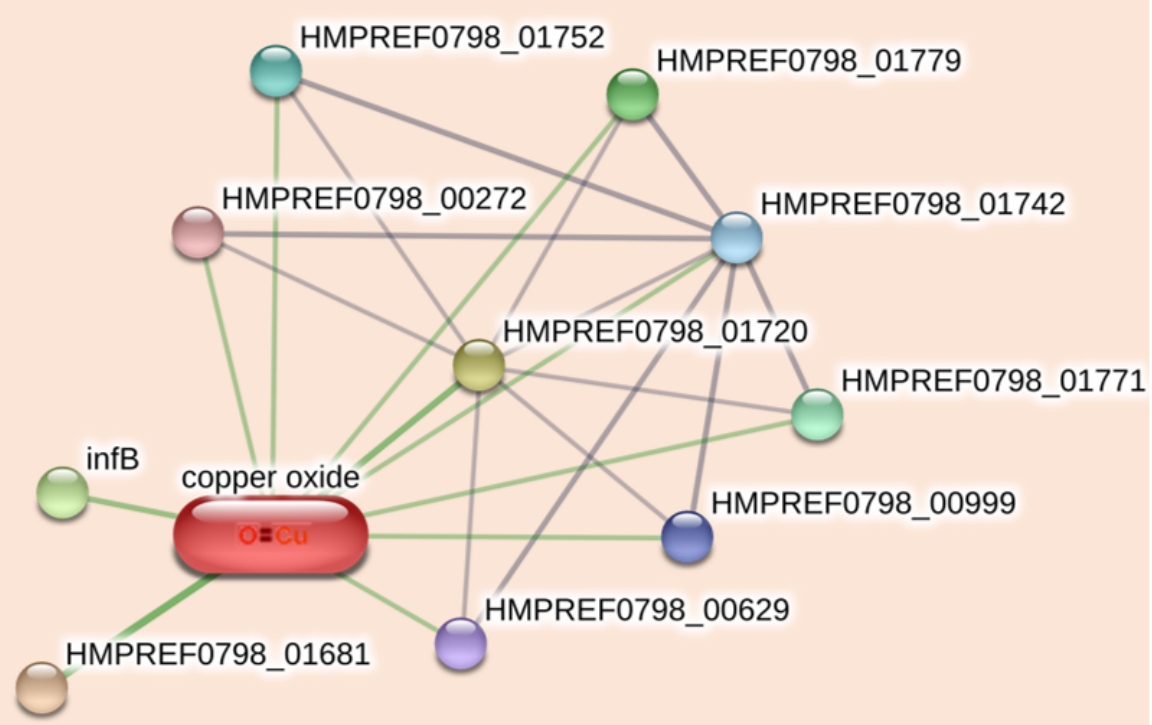
Figure 5. Compound protein interactions network of citrate CuO nanohybrid on S. hominis bacterial strain. Table 1. Effect of citrate functionalized CuO NPs on S. hominis bacterial strain.